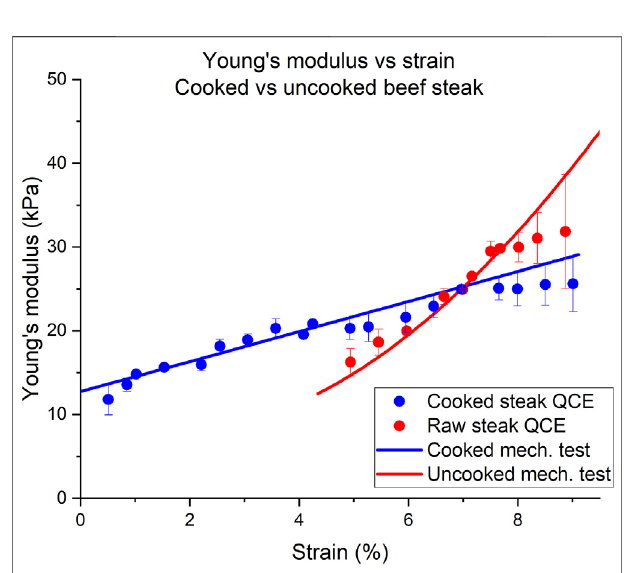
FIGURE 6 | Tangent Young ’ s modulus (YM) as a function of compressive strain for a half-cooked beef steak. The red and blue circles indicate Young ’ s modulus estimated for the cooked and uncooked halves of thesteakusingQCE,respectively.Thesolidlineswereobtainedfromthe slope of the stress-strain curve obtained from mechanical